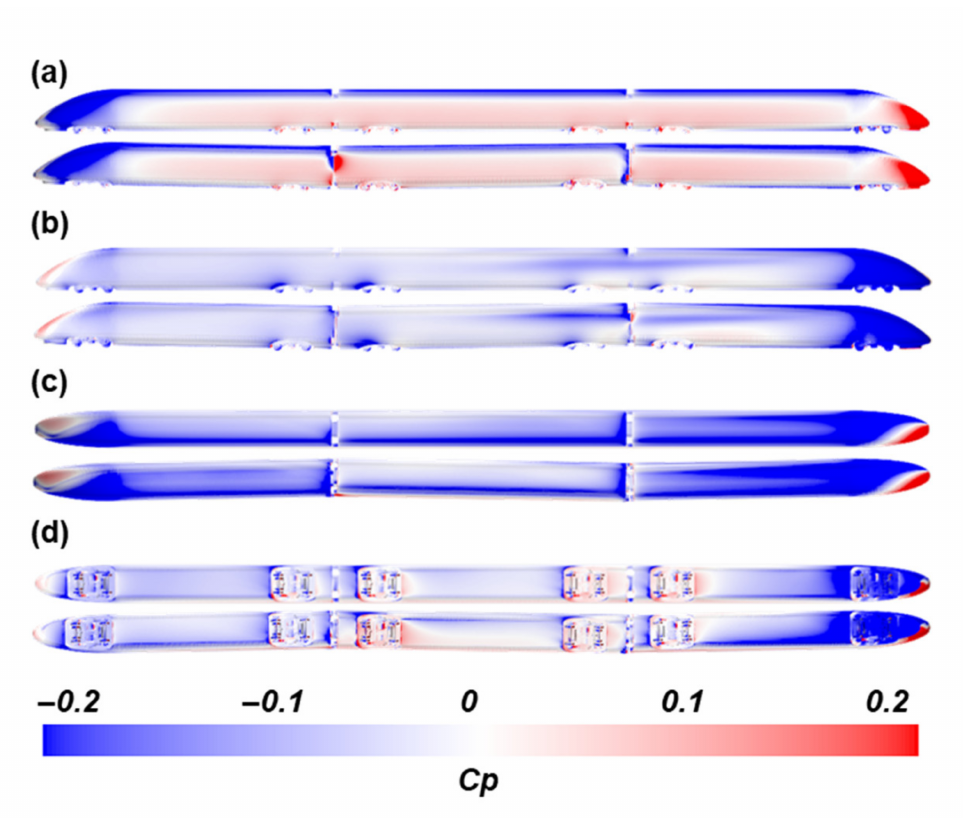
Figure 12. Distribution of c p of the train surfaces with and without the posture: ( a ) windward side; ( b ) leeward side; ( c ) roof; ( d ) bottom. The train with posture is shown in the bottom half of each